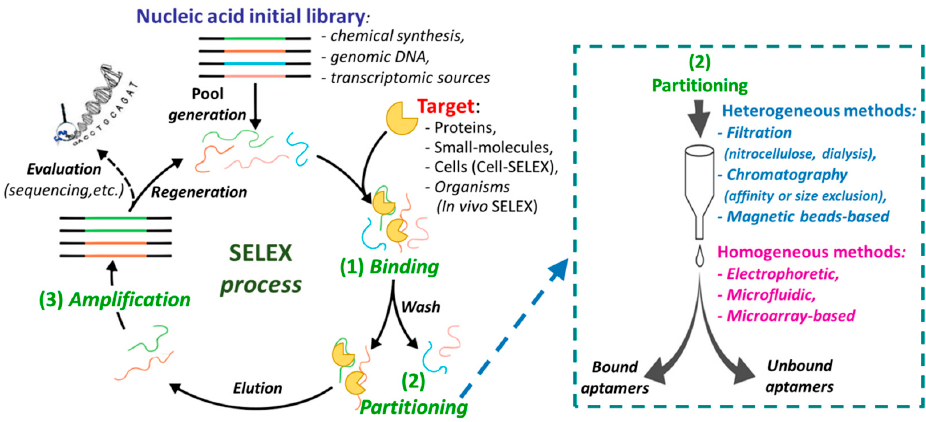
Figure 2. Schematic representation of the Systematic Evolution of Ligands by Exponential Enrichment (SELEX) process steps; on the right, available partitioning methods are listed.